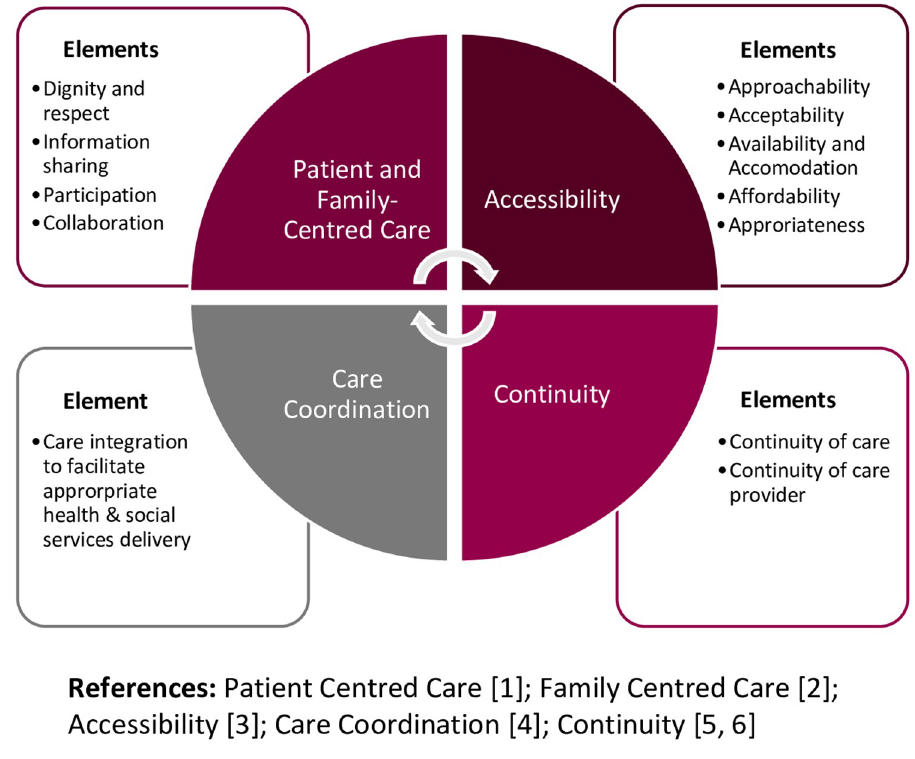
Fig 1. Health links core